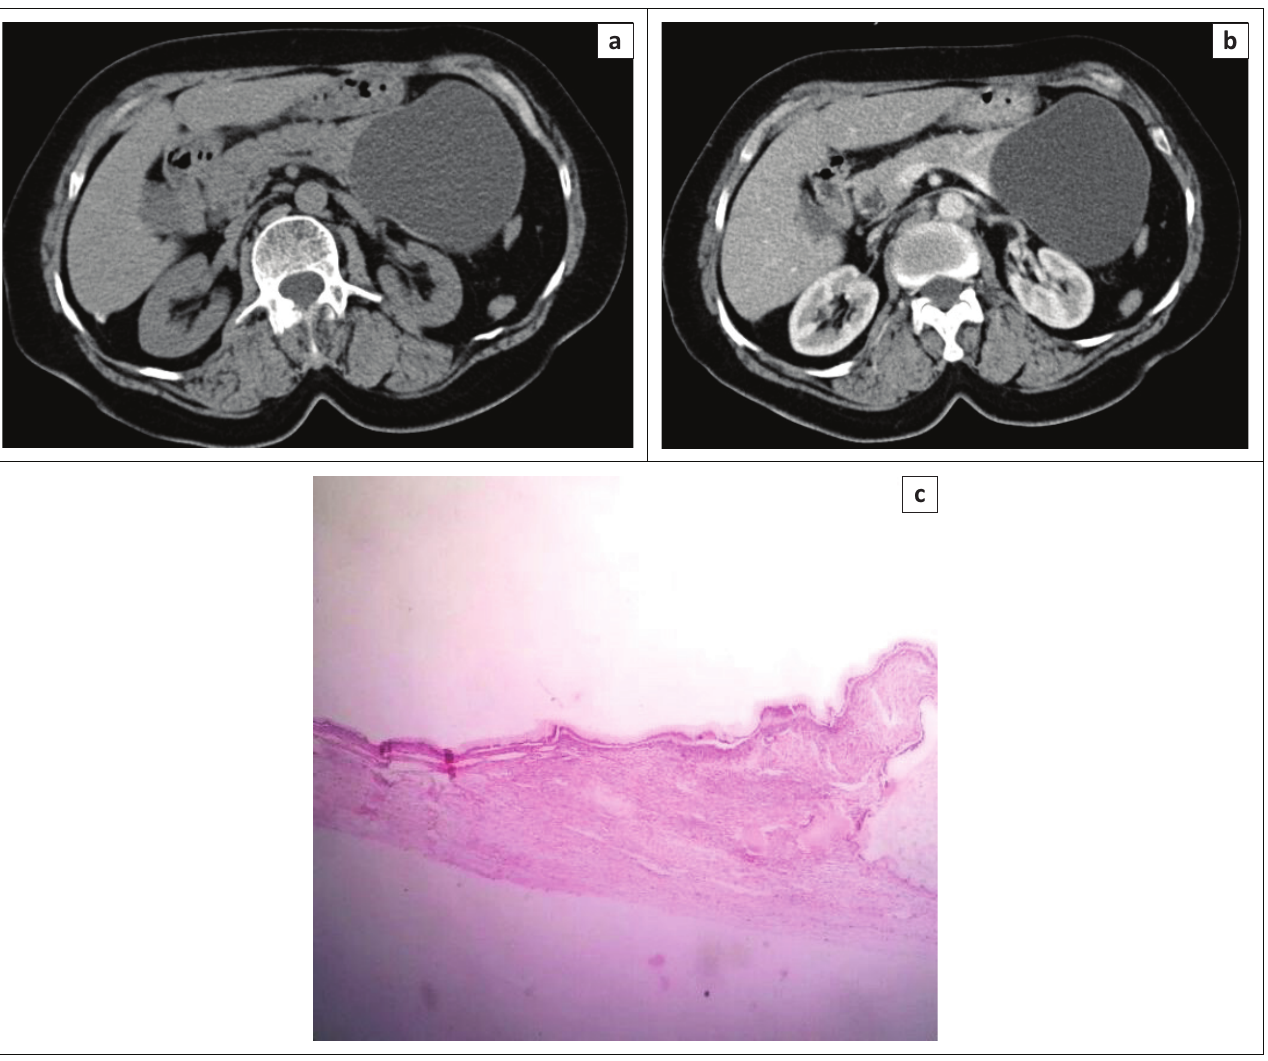
FIGURE 2: Axial non-contrast-enhanced computed tomography image (a) in a 49-year-old female patient showing large fluid attenuation cystic lesion in the tail of pancreas with a smooth external contour. Axial contrast-enhanced computed tomography image (b) in the same patient showing a non-enhancing cystic lesion in the tail of pancreas with subtle wall enhancement, suggestive of mucinous cystadenoma. Low power magnification (scanner 4X) photomicrograph (c) of the same patient confirmed the diagnosis of mucinous